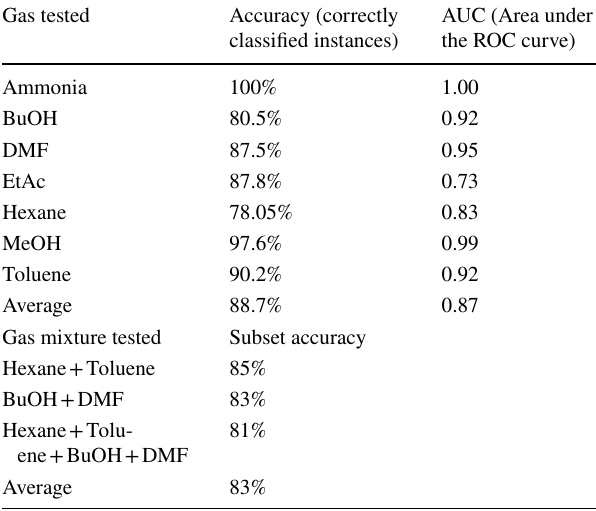
Table 1 Predictive accuracy of the machine learning (ML)